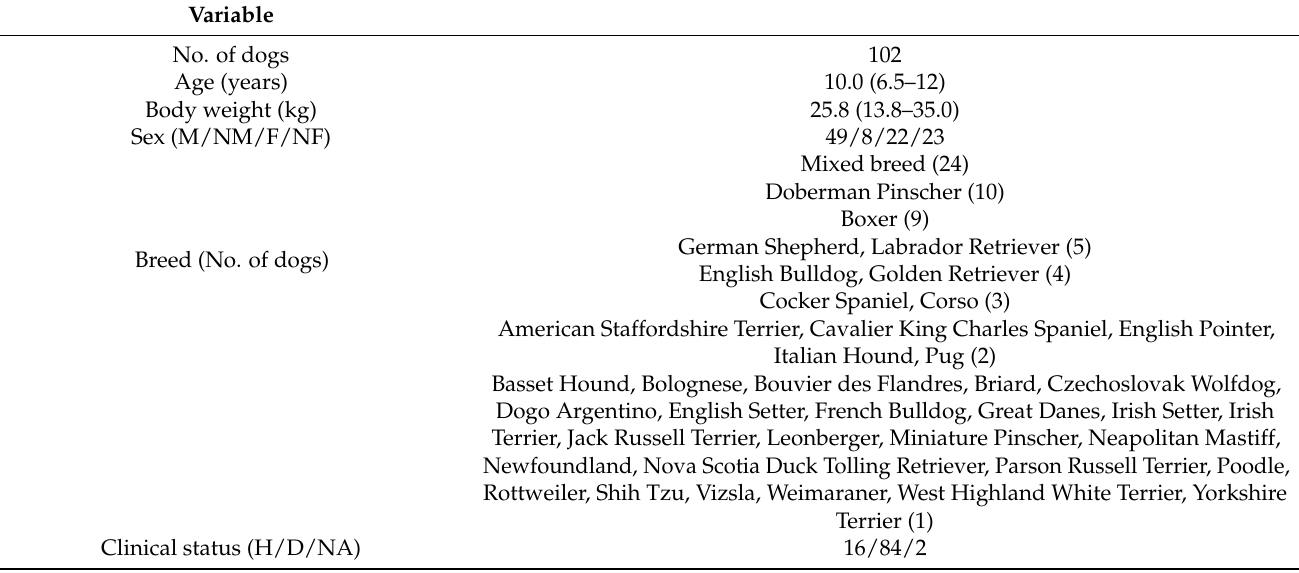
Table 2. Demographic data from dogs used in this